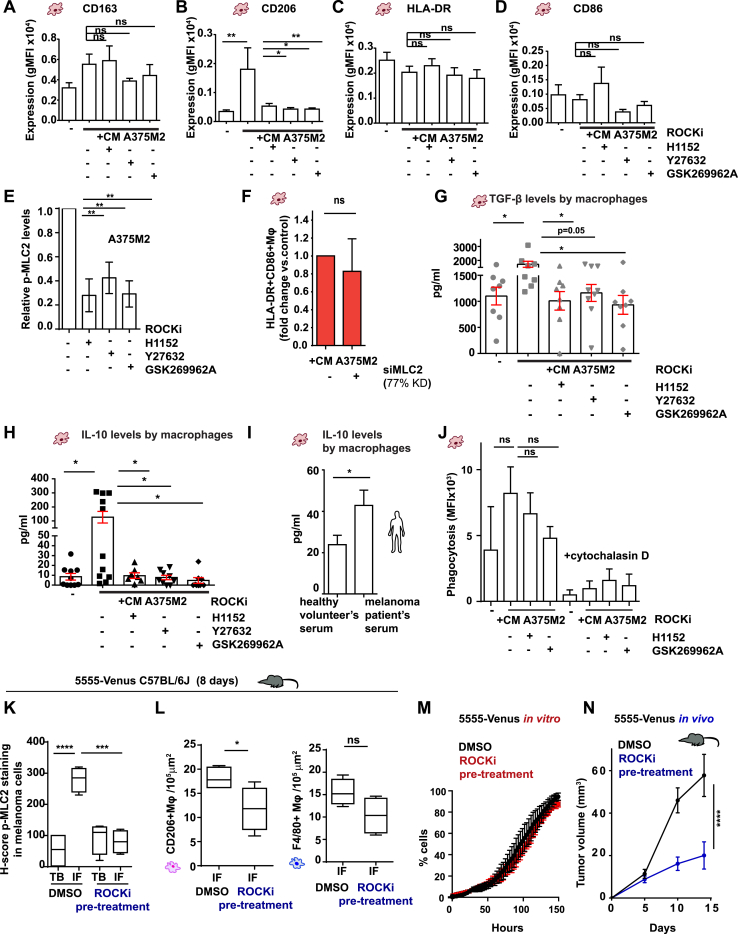
Remodeling of the AATME after Manipulation of Myosin II Activity In Vivo, Related to Figure 5(A–D) Expression levels (gMFI) of (A) CD163, (B) CD206, (C) HLA-DR and (D) CD86, in macrophages after treatment with CM A375M2, CM A375M2+H1152, CM A375M2+Y27632, CM A375M2+GSK269962A or culture media only (-) (n ≥ 5 different heathy donors).(E) Relative p-MLC2 levels in A375M2 cells treated with H1152, Y27632 or GSK269962A ROCK inhibitors (n = 4).(F) HLA-DR+CD86+ macrophages after treatment with CM A375M2 depleted from MLC2. Data are presented as fold changes versus the control (n = 4).(G and H) (G) Macrophage secretion of TGF-β (pg/ml) and (H) IL-10 (pg/ml) after treatment with CM A375M2, CM A375M2+H1152, CM A375M2+Y27632, CM A375M2+GSK269962A or culture media only (-) (n = 8; 8 different healthy donors).(I) Concentration of IL-10 in macrophages induced by melanoma patient-derived sera or healthy volunteer-derived sera (n = 2; 2 different healthy donors for macrophages; n = 5 volunteers-derived sera and n = 9 melanoma patients-derived sera).(J) MFI for phagocytosed zymosan particles by macrophages after treatment with CM A375M2, CM A375M2+H1152 or CM A375M2+GSK269962A, with or without cytochalasin D (5 μM) (n = 2).(K) H-score for p-MLC2 expression of melanoma cells in TB and IF.(L) (Left) CD206+ macrophages and (right) F4/80+ macrophages in the IF.(K and L) Tumors 8 days post-intradermal injection of DMSO (vehicle)-pre-treated and ROCKi-pre-treated Venus- 5555 cells (n = 5 mice/group).(M) Percentage of viable DMSO (vehicle)-pre-treated and ROCKi-pre-treated Venus- 5555 cells in vitro as measured by IncuCyte (n = 3). Viability was measured after drug removal.(N) Tumor volume (mm3) in C57BL/6J mice after intradermal injection of DMSO (vehicle)-pre-treated and ROCKi-pre-treated Venus- 5555 cells (days: 0-14) (n = 13 tumors for DMSO group and n = 14 tumors for ROCKi group; n = 7 mice/group).(A–J, M, and N) Graphs show mean ± SEM. (K–L) Boxplots show 10-90 percentile. (A-E, J, and K) One-way ANOVA with Tukey post hoc test. (F–H and L) t test. (I) t test with Welch’s correction. (N) Two-way ANOVA with Bonferroni post hoc test.ns > 0.05,∗p < 0.05,∗∗p < 0.01,∗∗∗p < 0.001,∗∗∗∗p < 0.0001.